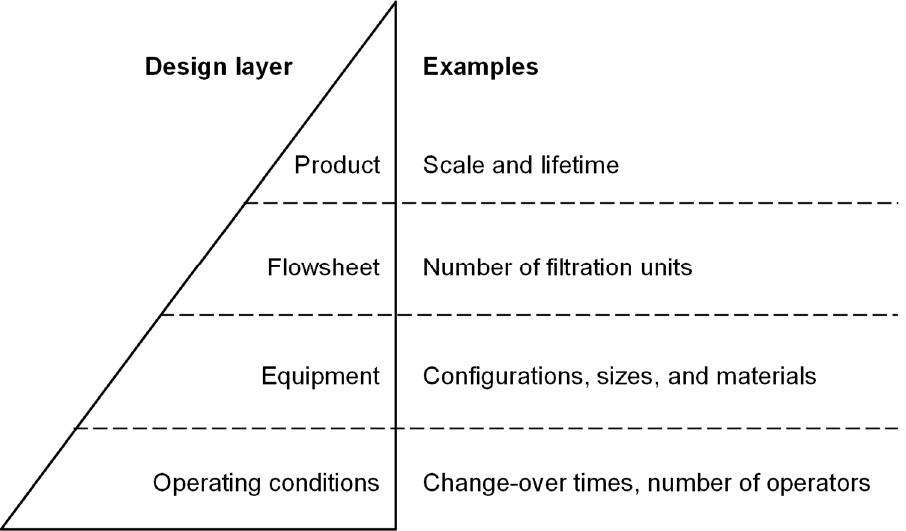
Figure 4. Decision layers within the framework for alternative generation in DP (drug product) manufacturing.